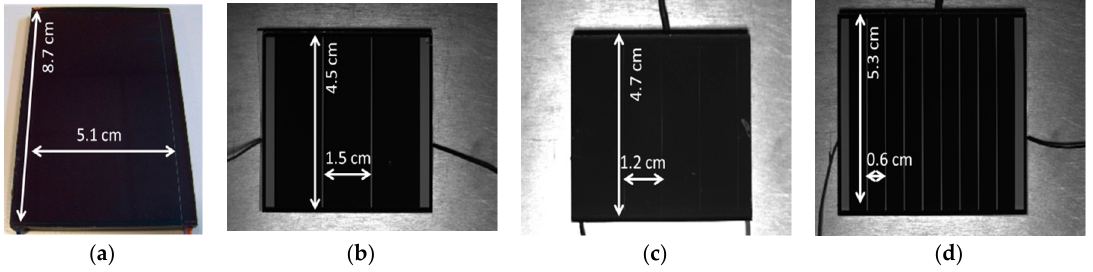
Figure 1. Visual images of a-Si mini-modules: ( a ) TF-1; ( b ) TF-3; ( c ) TF-4; and ( d ) TF-9.